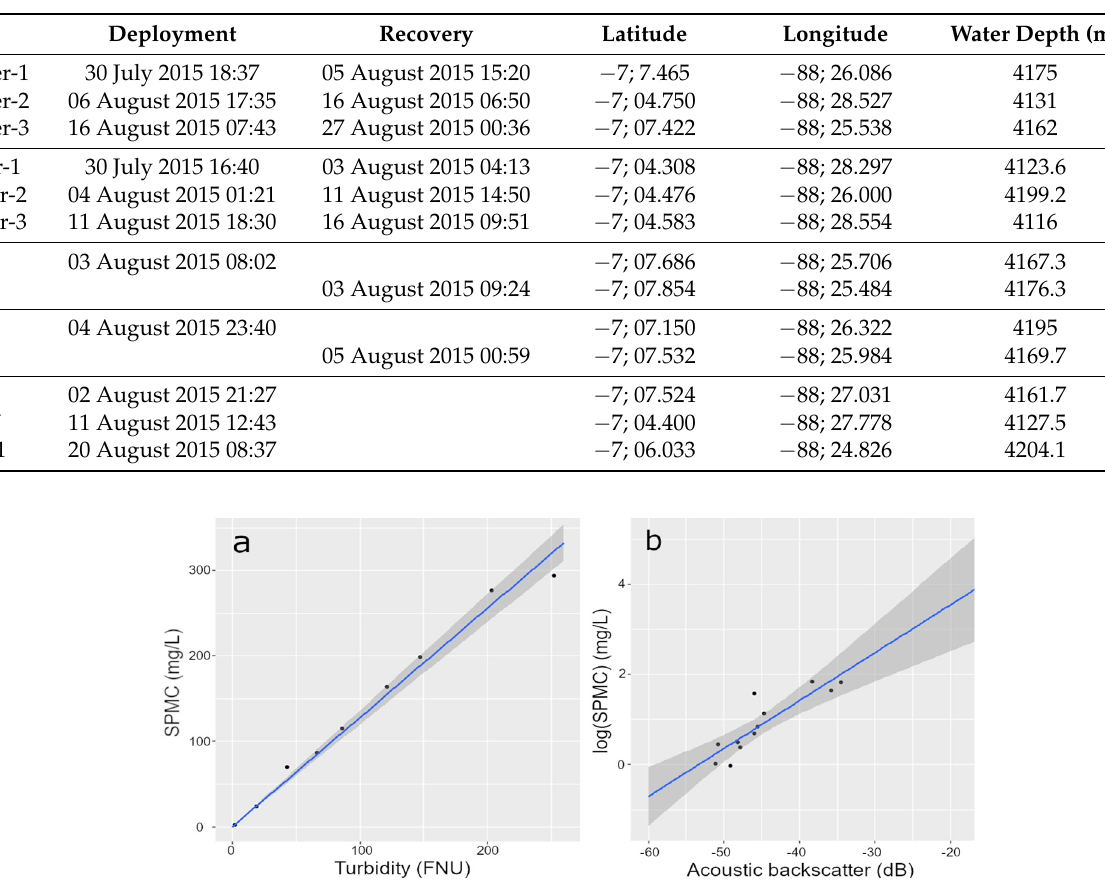
Figure 3. ( a ) Seapoint FNU–SPMC linear relationship (R 2 = 0.98) using calibration suspensions prepared with surface sediments from multicore station #34_MUC-6 closest to the experiment site (Figure 1). ( b ) Linear relationship (R 2 = 0.75) between the acoustic backscatter from the Aanderaa recording current meter (RCM) and the natural logarithm of the Seapoint SPMC, both mounted on the EBS. The shaded band is a pointwise 95% confidence interval on the fitted line.